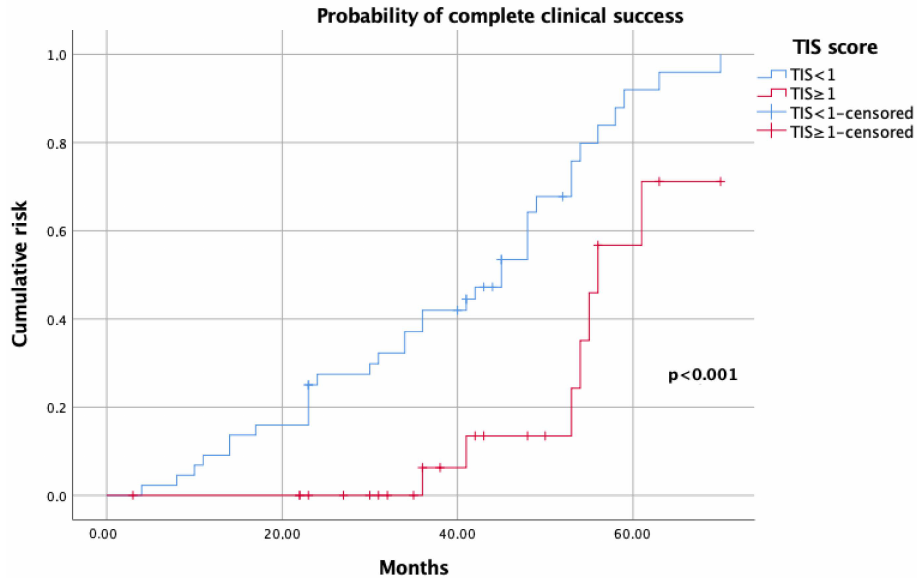
Figure 1. Kaplan–Meier analysis showing probability of complete clinical success, according to TIS score.